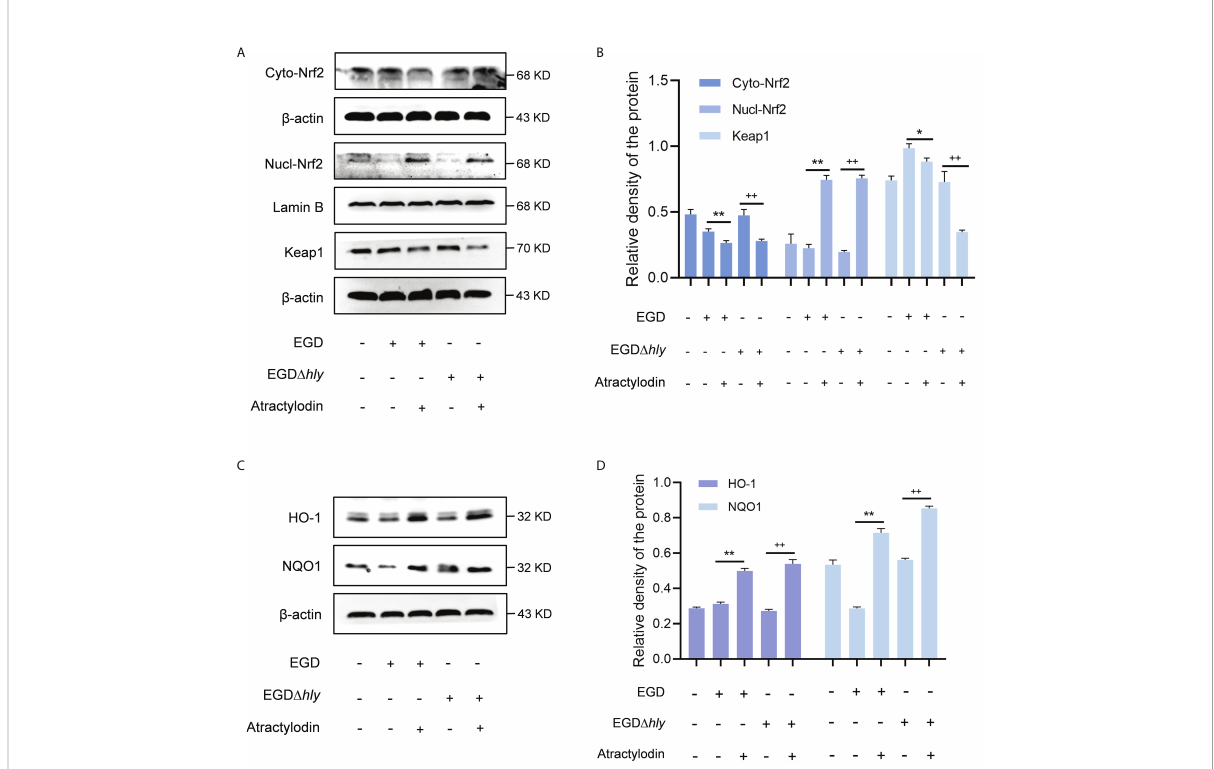
FIGURE 6 Atractylodin facilitated the nuclear translocation of Nrf2, thereby upregulated the antioxidant enzyme expression in L. monocytogenes infected macrophages. (A, B) Western blot analysis of effects of atractylodin on the Keap1-Nrf2 signaling pathway during L. monocytogenes infection. Nuclear and cytoplasmic protein from J774A.1 cells were prepared and analyzed by western blotting for the assessment of the nuclear translocation of Nrf2. (C, D) The levels of Nrf2-targeted typical phase 2 detoxifying enzyme NQO1 and the stress response protein HO-1 in J774A.1 cells infected with wildtype L. monocytogenes strain EGD and the hly -de fi cient mutant EGD D hly in the presence or absence of atractylodin. (B, D) The levels of Cyto-Nrf2, Keap1, NQO1 and HO-1 relative to b -actin and Nucl-Nrf2 relative to Lamin B determined using densitometry were shown. Data are represented as the mean ± SEM. * P < 0.05 and ** P < 0.01 vs the EGD-infection group; ++ P < 0.01 vs the EGD D hly -infection